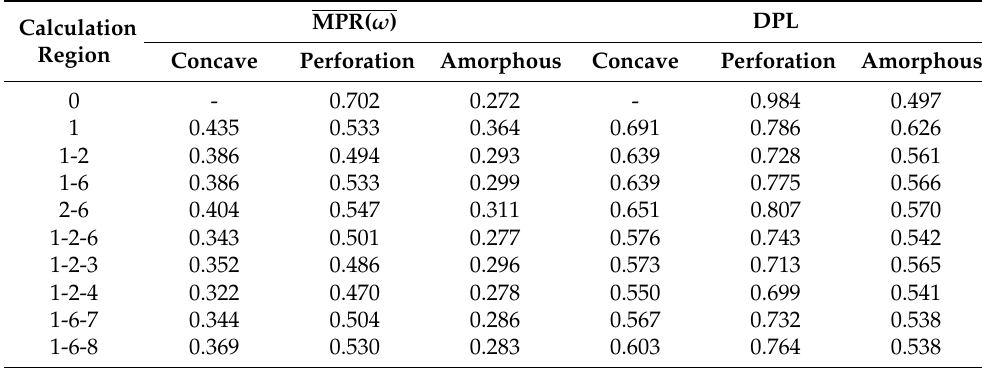
Table 1. MPR ( ω ) and DPL in the same region with different structures.